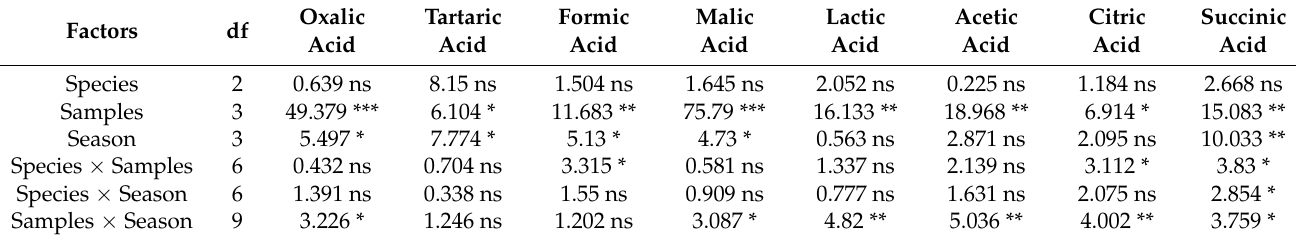
Table 3. Soil LMWOAs of three rhododendron